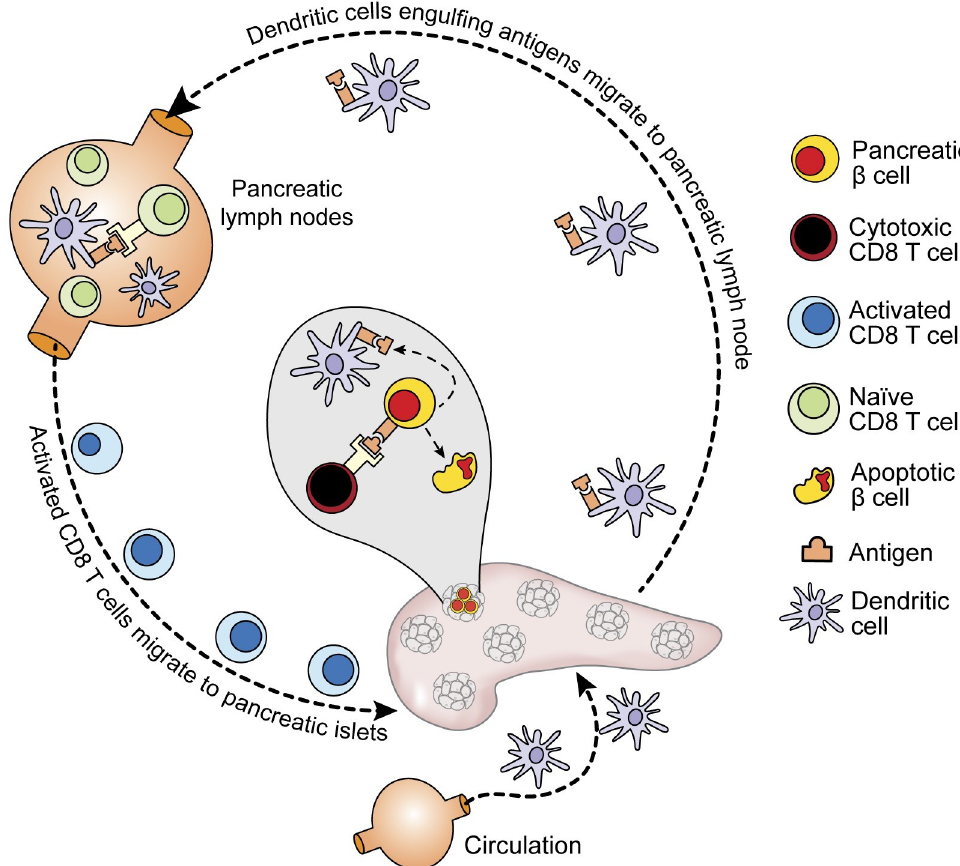
Fig 2. Schematic diagram of T1D progression in circulation, islets, and PLN. The legend shows the cell types and autoantigens used as agents in the ABM structure.